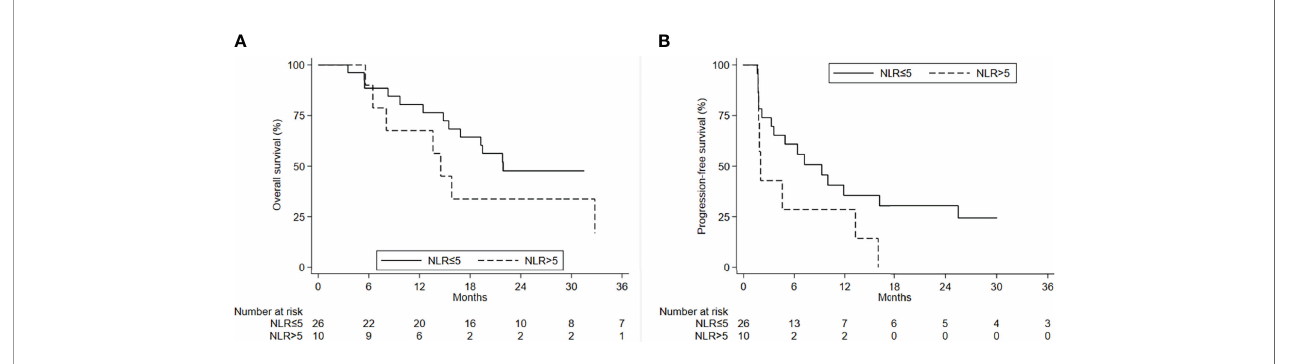
FIGURE 5 | (A) OS and (B) PFS by